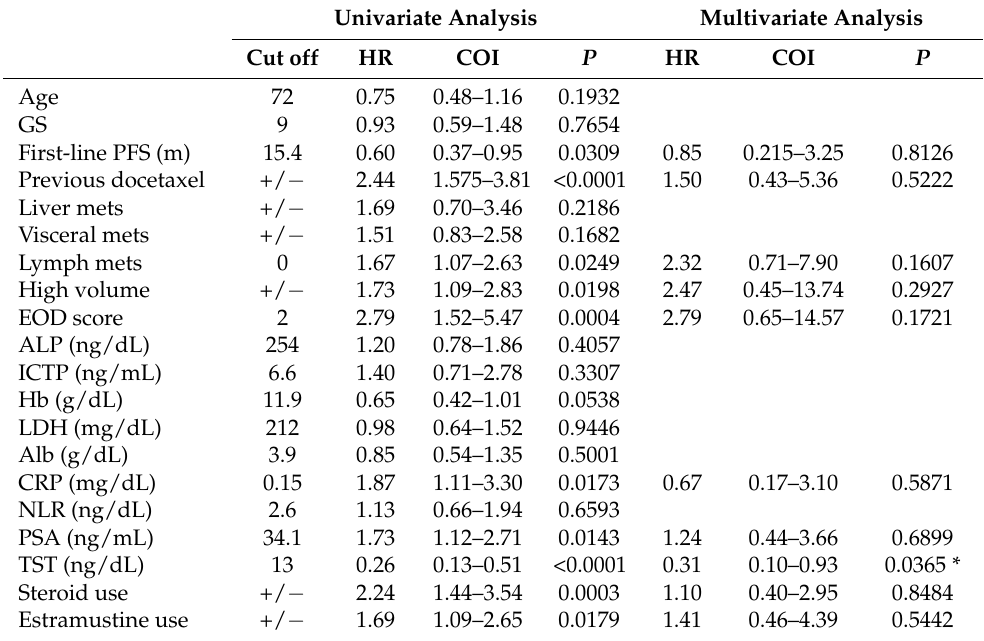
Table 2. Predictive factors of PFS in enzalutamide- and abiraterone- treated